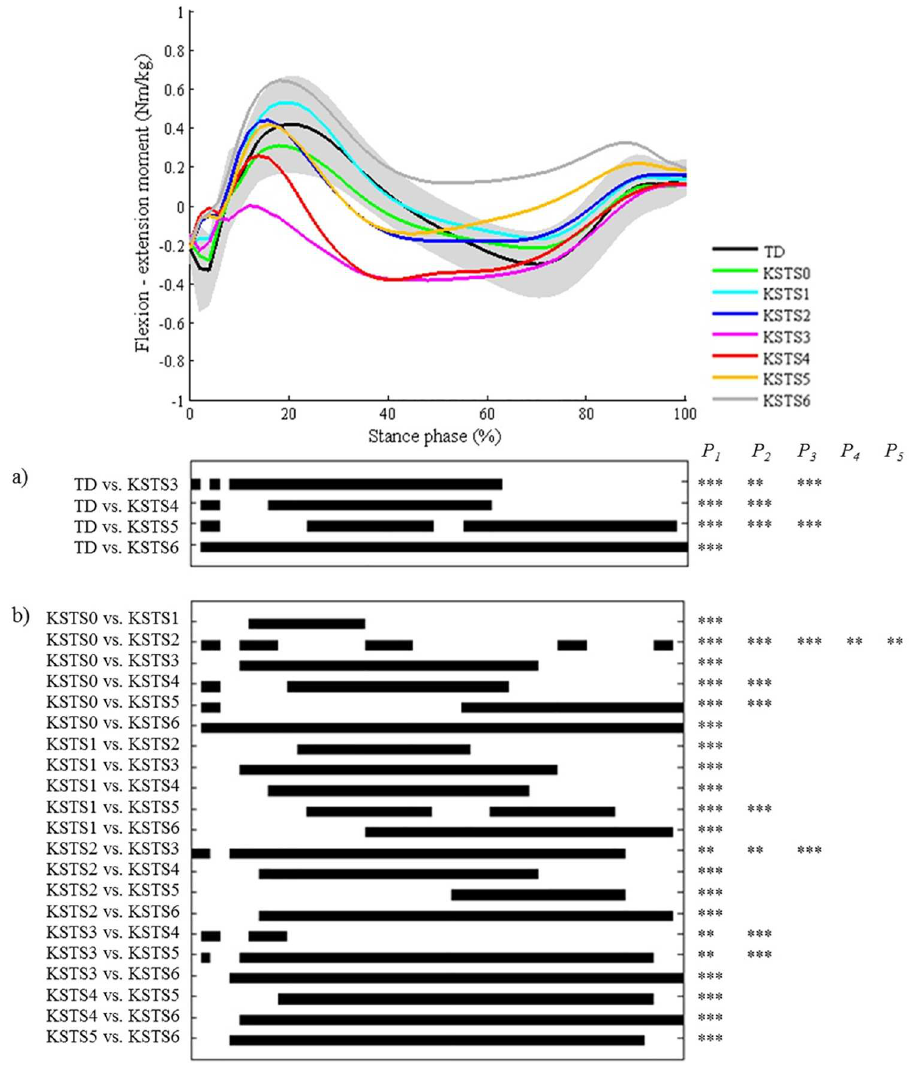
Fig 15. Knee during stance in the sagittal plane (KSTS). Top graph shows the mean kinetic angle of TD gait and of each consensus-based pattern of the knee duringstance in the sagittal plane. Black bars indicate significantgait phases duringwhich the SPM{t} statistic exceededthe critical threshold. Panel ( a ) shows results of hypothesis2 (i.e. unpairedt-tests, α = 0.01); panel( b ) shows results of hypothesis3 (i.e. post-hoc unpairedt-tests, α = 0.0005). * p < 0.01, ** p < 0.001, *** p < 0.00001.P 1 indicatesthe p-value of the first cluster duringthe stance phase, P 2 the second cluster,